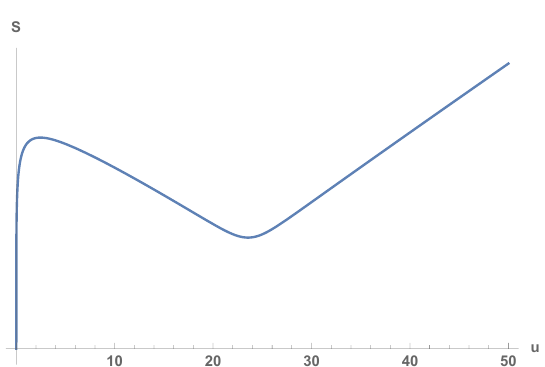
Figure 5 . The von Neumann entropy of the black hole, as computed from the generalized entropy on the quantum extremal surface, at early times after coupling to the bath. In this plot, we have T 0 = 1 and T 1 (cid:0) T 0 = 10 (cid:0) 10 2 (cid:25) T 0